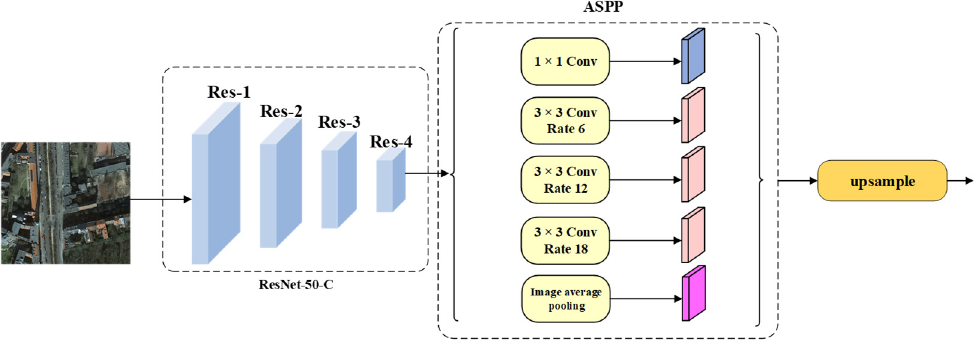
Figure 7. Structure of Baseline.